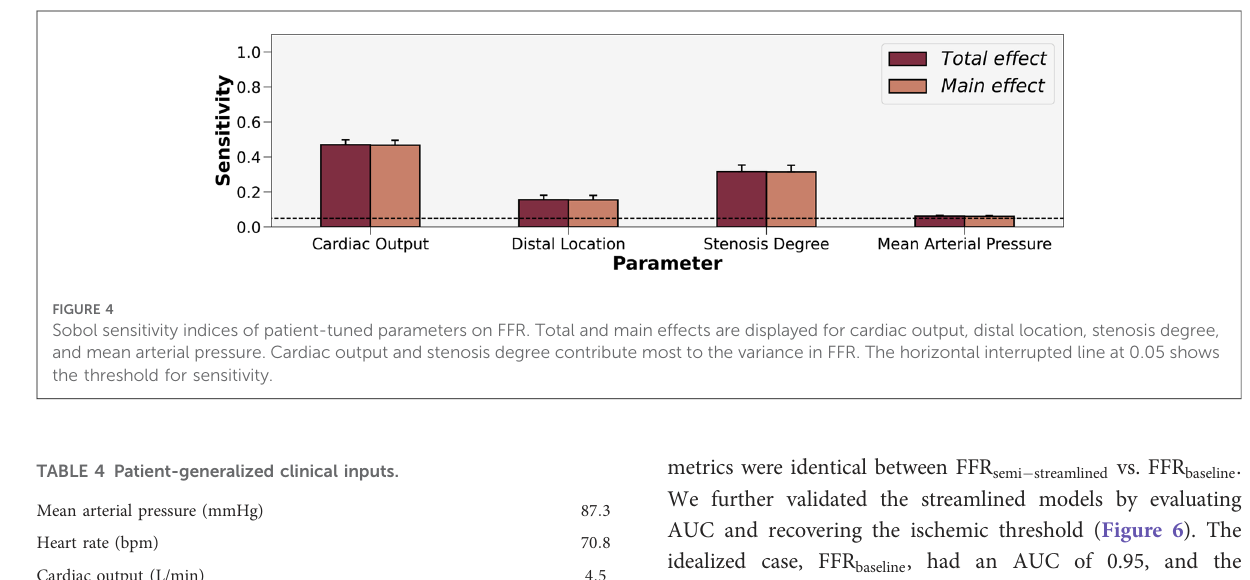
TABLE 5 Diagnostic performance of FFR streamlined , FFR semi (cid:1) streamlined , and FFR baseline to detect ischemic stenoses at the clinical threshold of 0.80.